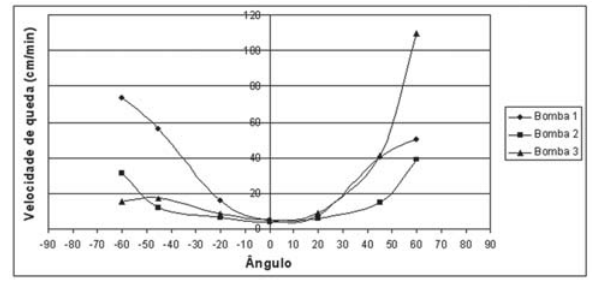
Fig. 3 – Perfil de velocidade de queda nos três modelos de bomba